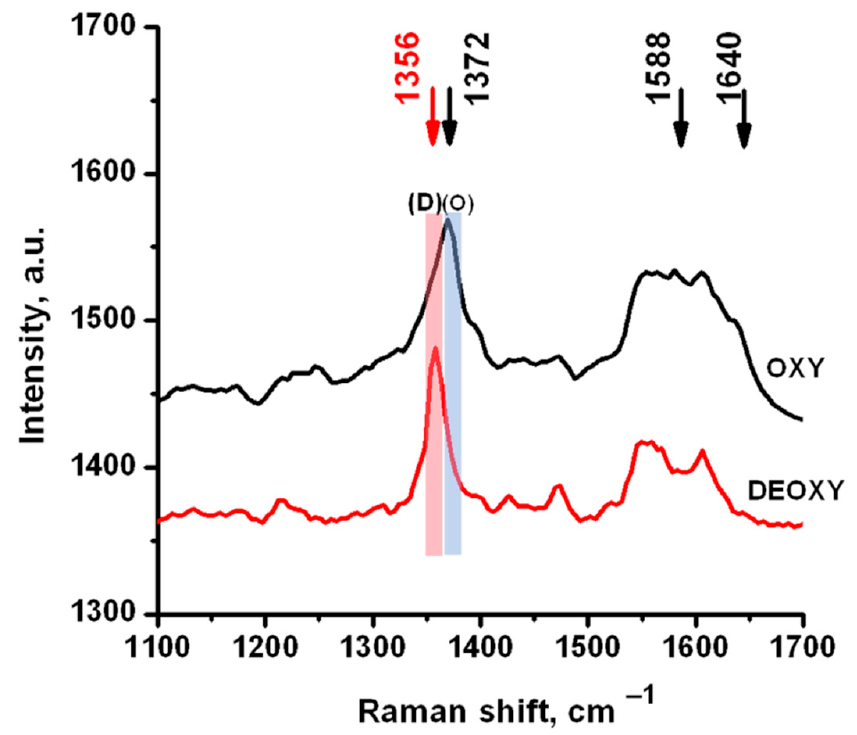
Figure 2. Raman spectra of oxyHb and deoxyHb, measured in oxygenated and deoxygenated RBC with 488 nm wavelength laser excitation. (O) and (D) mark the wavenumber ranges for mapping of ν 4 band: oxyHb (1365–1380 cm − 1 ) and deoxyHb (1350–1360 cm − 1 ), respectively. Peaks for oxyHb 1588 cm − 1 ( ν 37 ) and 1640 cm − 1 ( ν 10 ) are also shown. Peak assignment according to [21].